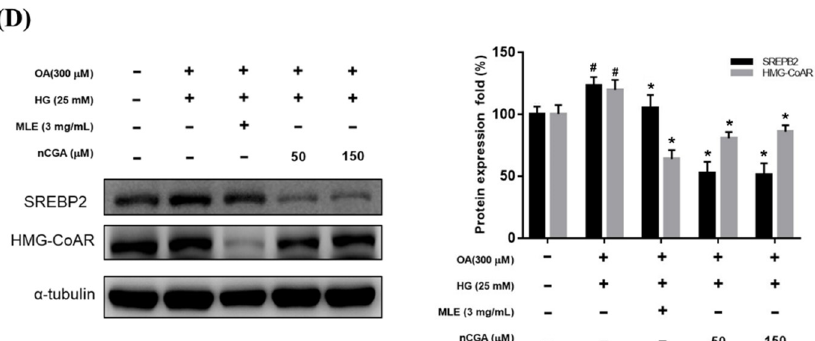
Figure 4. Effects of MLE and nCGA on multiple signaling pathways in OH − induced HepG2 cells. HepG2 cells were co-treated with OH, MLE (3 mg/mL), and nCGA (50 or 150 µ M) at 37 ◦ C for 24 h. Protein extracts were measured by Western Immunoblotting; α -tubulin was used as an internal control. MLE and nCGA activated ( A ) pAMPK/AMPK and ( B ) PPAR α /CPT-1 signaling pathways in OH-induced HepG2 cells, but reduced ( C ) SREBP-1/FASN and ( D ) SREBP-2/HMG-CoAR protein expressions. Values are the mean ± SD of three independent experiments. # p < 0.05 vs. the control group. * p < 0.05 vs. the OH group.